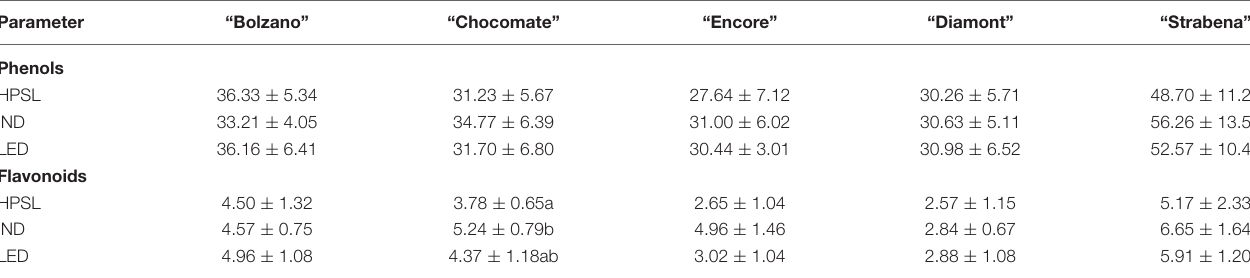
Significantly different means are labeled with different